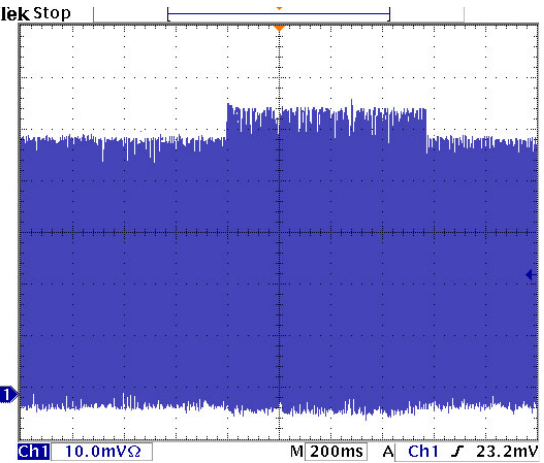
Figure 4. Oscillogram of pump laser pulse when OPO is in cw mode-locked regime (lower level) and when OPO generation is blocked (upper level).